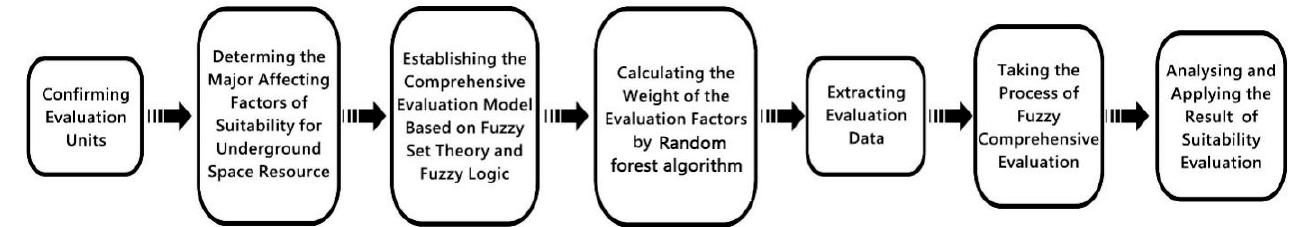
Figure 7. Process of suitability evaluation of USR.